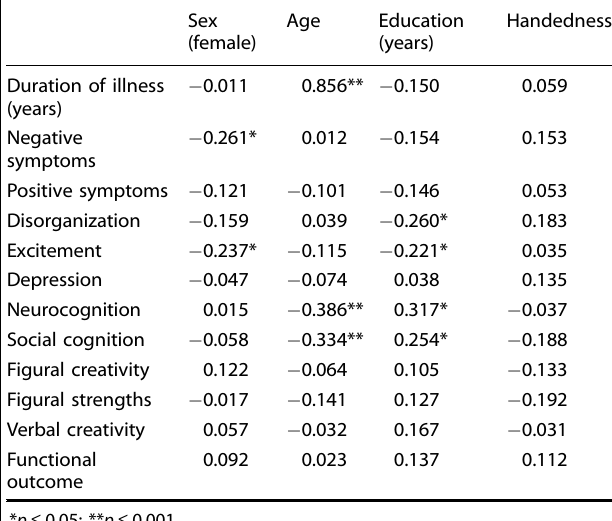
Table 2. Correlations between sociodemographic variables with clinical characteristics, neurocognition, social cognition, creativity, and functional